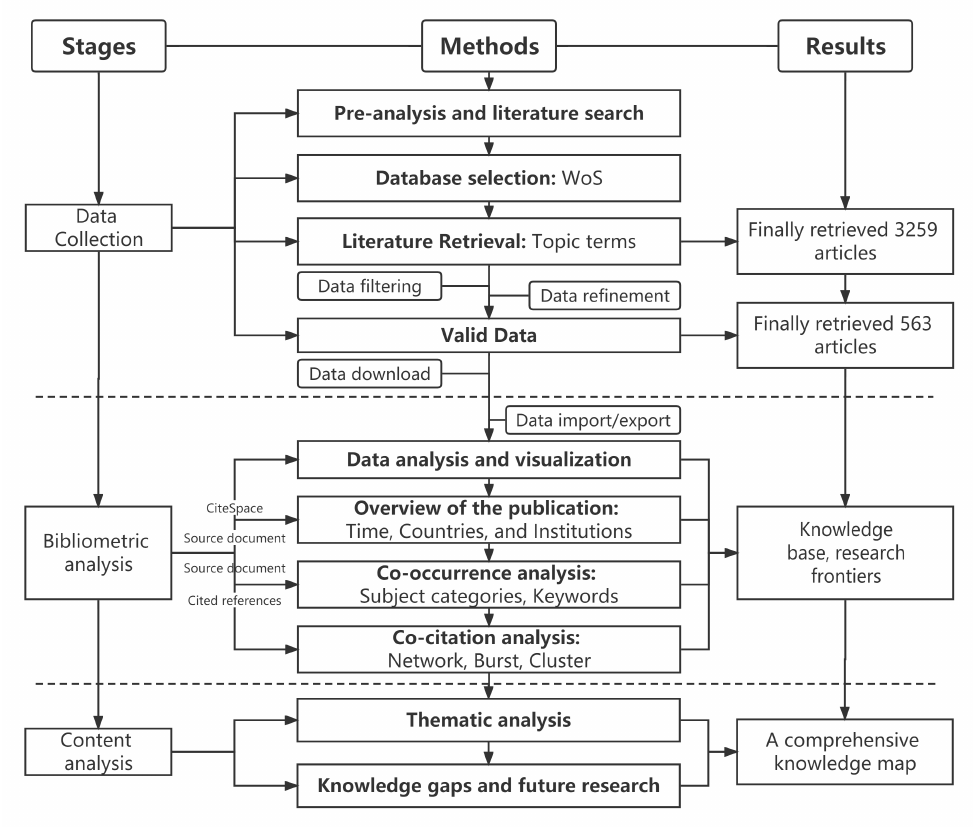
Figure 1. Research